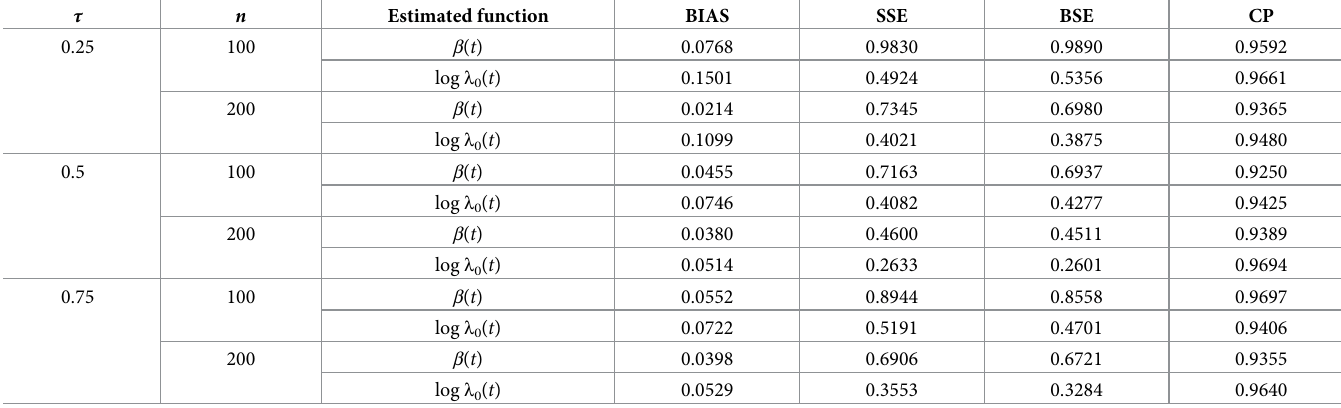
Table 2. BIAS, SSE, BSE and CP of the estimated functions in Case II at different τ .